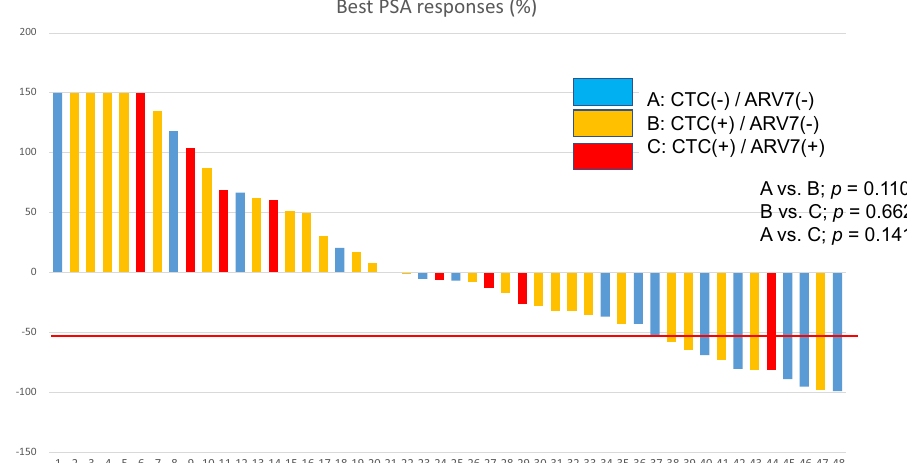
Figure 2. Waterfall plot of the best PSA change rate after four or more cycles of cabazitaxel. Group A, CTC (−) / AR-V7 (−); Group B, CTC ( +) / AR-V7 (−); Group C, CTC ( +) / AR-V7 ( +). A vs. B, p = 0.318; B vs. C, p = 0.391; A vs. C, p = 0.685. AR-V7, androgen splicing variant-7; CBZ, cabazitaxel; CRPC, castration-resistant prostate cancer; CTC, circulating tumor cell; PSA, prostate specific antigen; (−), negative; ( +), positive.